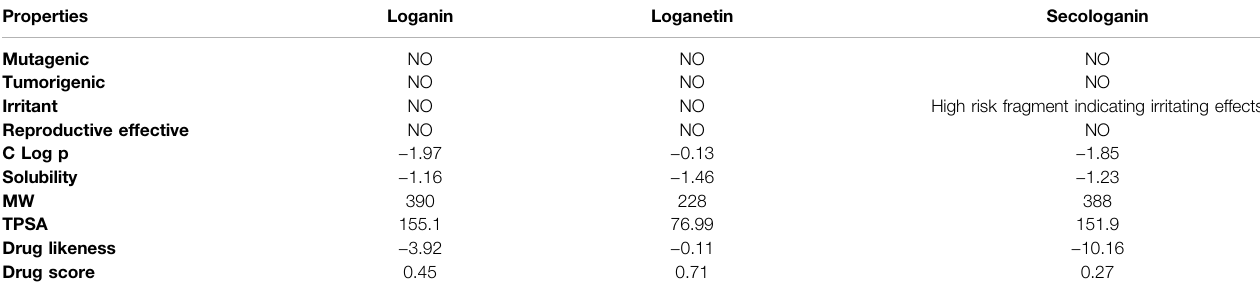
TABLE 6 | Drug likeness prediction and toxicity of loganin, loganetin, and secologanin.